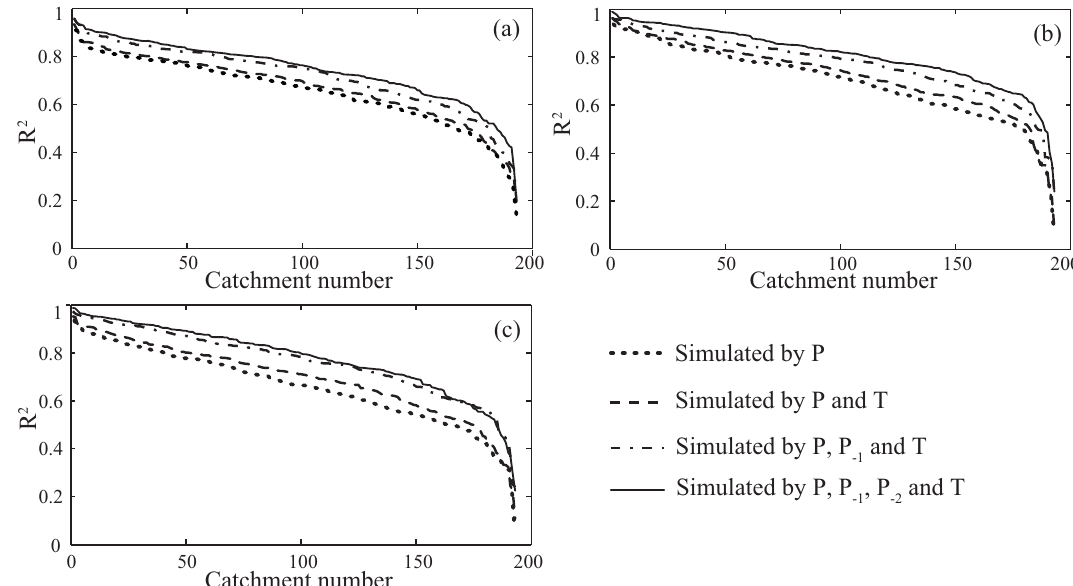
Fig. 3. Statistical distributions of coefficient of determination ( R 2 ) in elasticity esimation for (a) annual total runoff, (b) annual surface runoff and (c) annual subsurface runoff. Note that P represents the current year’s precipitation, P − 1 represents last year’s precipitation, P − 2 represents the year before last year’s precipitation and T represents the current year’s mean